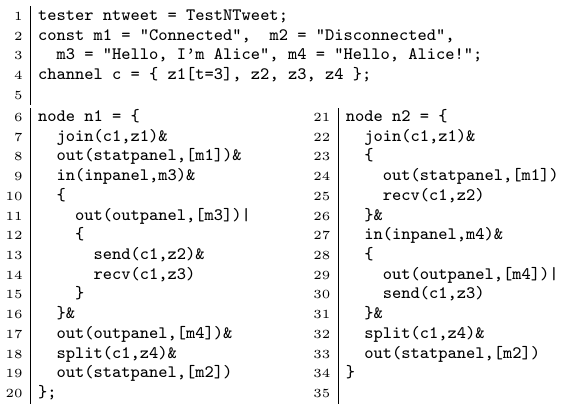
Figure 7: Script representing T-Net of Figure